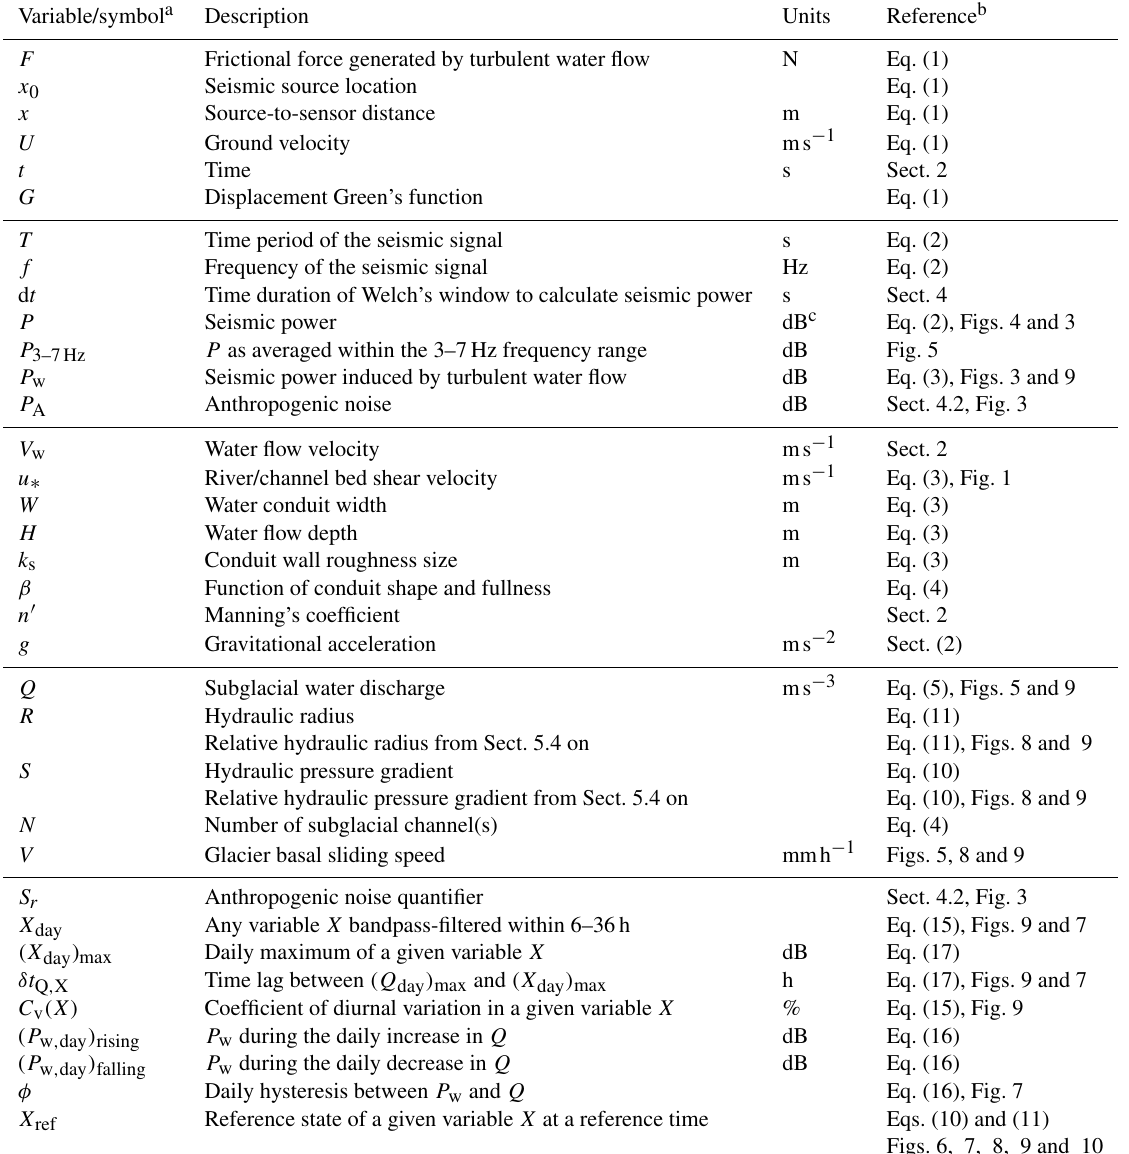
Table C1. Summary of all variables, physical quantities and mathematical functions used in the main text. Variable/symbol